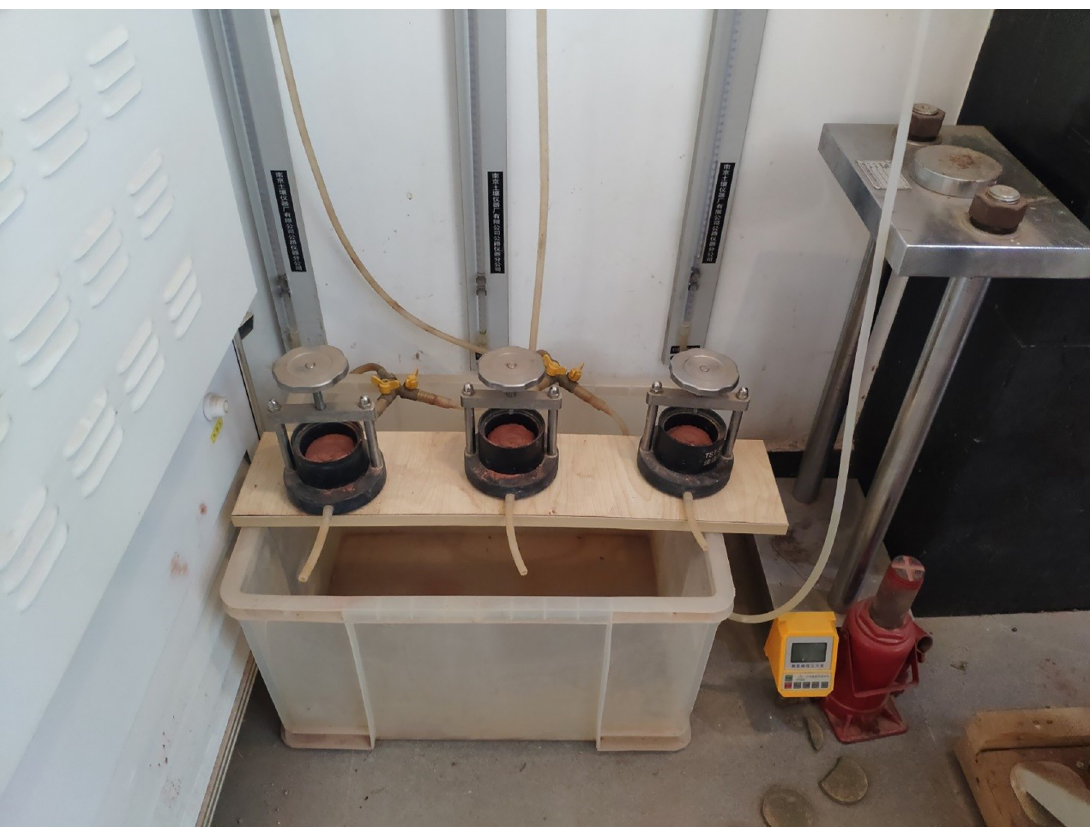
Fig 3. Mud film permeability